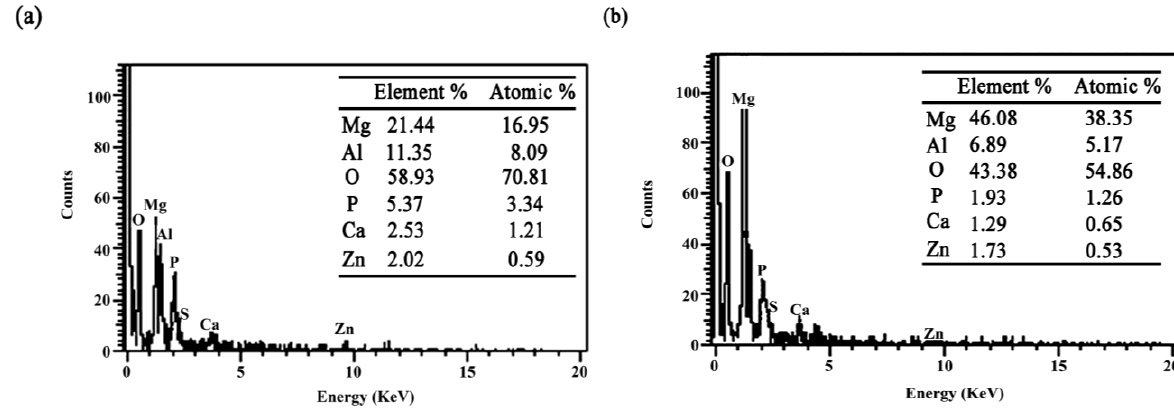
Figure 7. Compositions of the corrosion film formed ( a ) in the absence of SRB in Figure 6a at Point A; and ( b ) in the presence of SRB in Figure 6c at Point